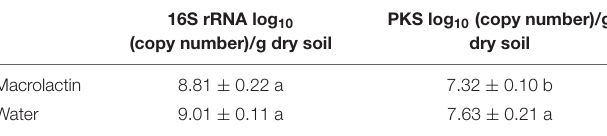
TABLE 3 | Real-time PCR quantification of 16S rRNA gene and PKS gene.